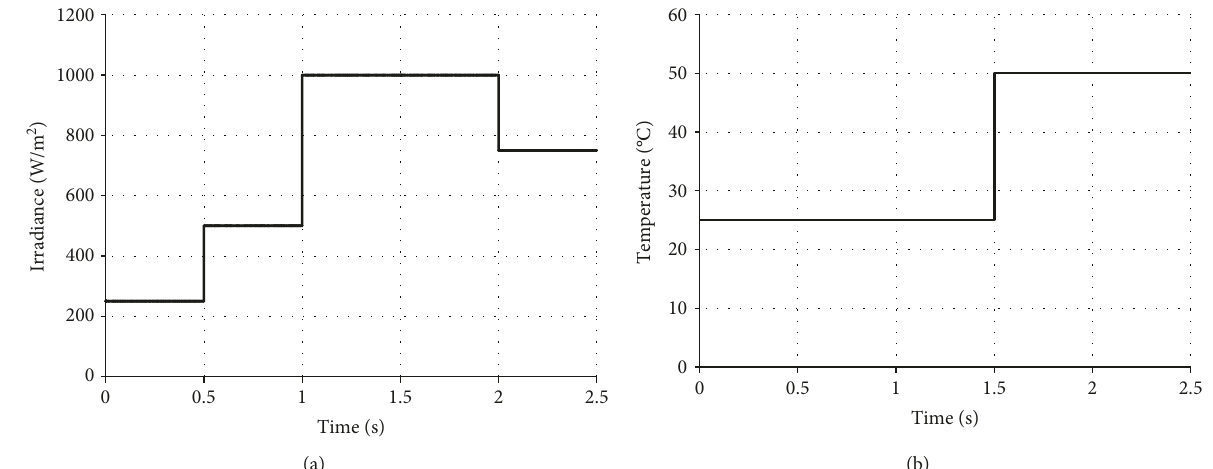
Figure 7: Irradiance (a) and temperature (b) fl uctuations used in the simulation.